Question: Does the plotted quantity increase or decrease?
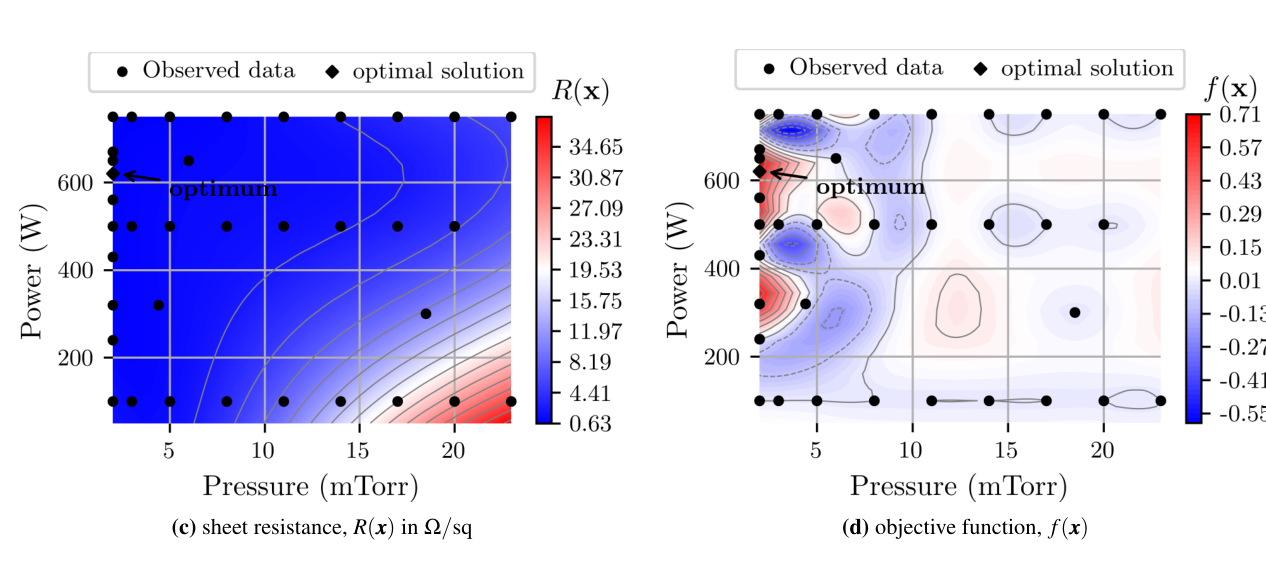
Answer: decreasing